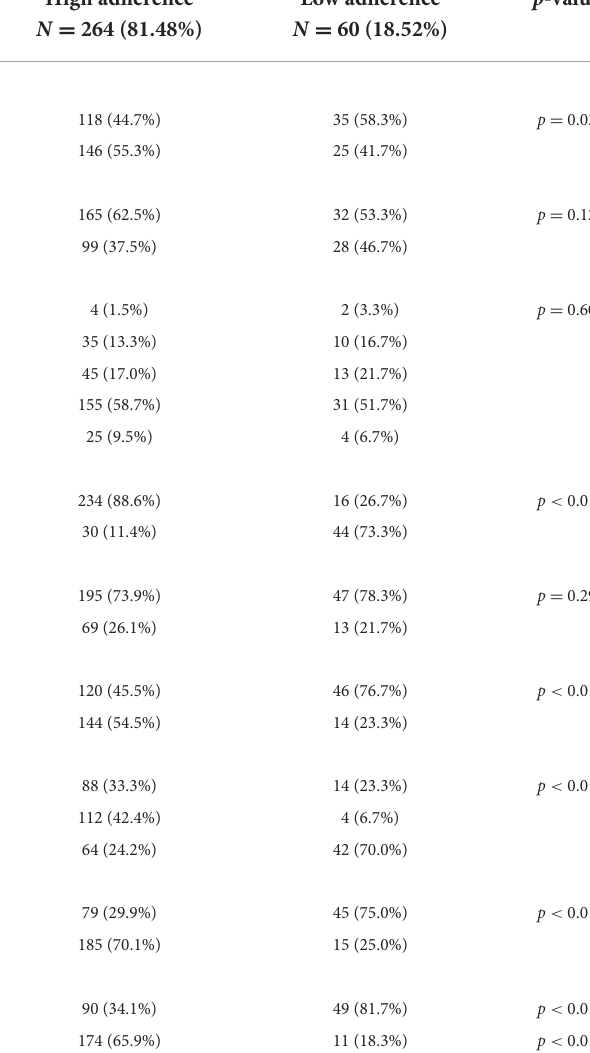
TABLE 2 Associated factors to adherence levels among PLWH ( n =